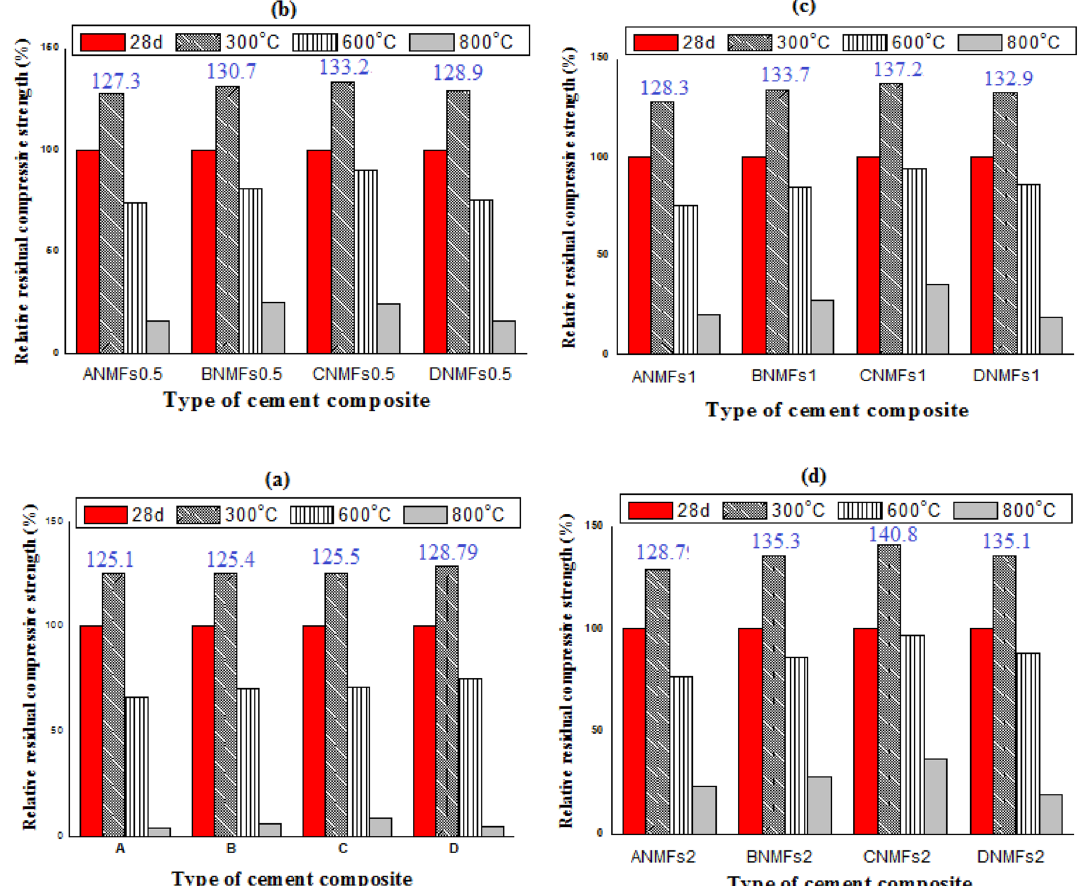
Figure 11. Relative residual compressive strength values for different fired cement composites after slow cooling in